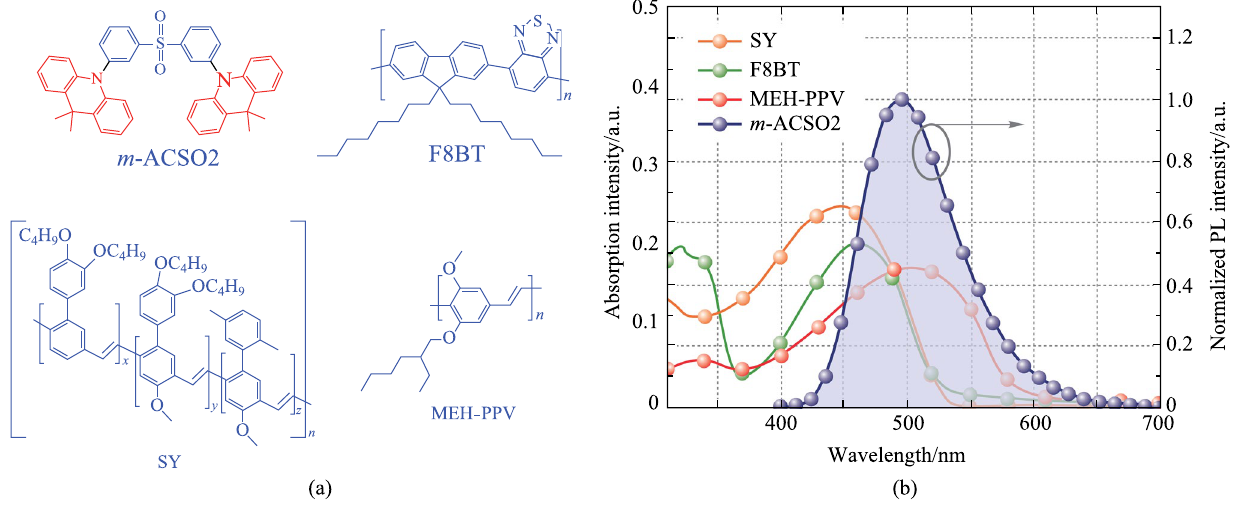
Fig. 2 a Chemical structures of the molecules used in this study. b PL spectrum of m -ACSO2 and absorption spectra of SY, F8BT and MEH- PPV in thin films,